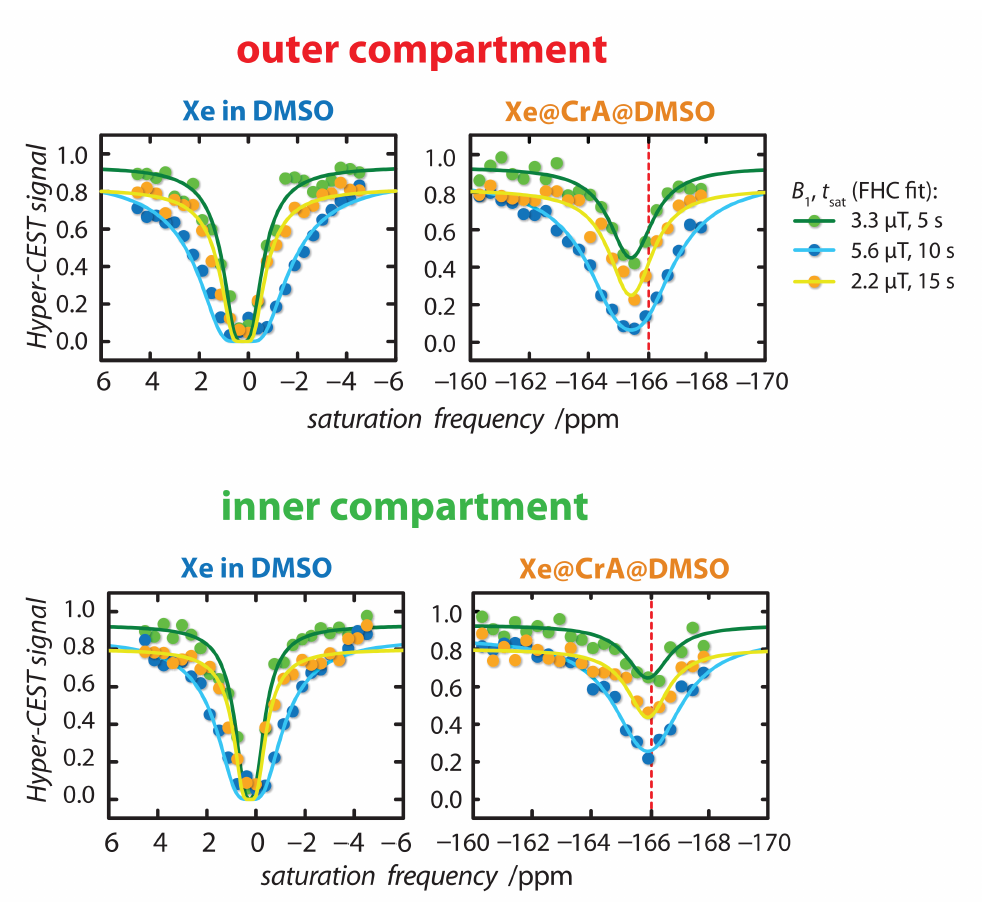
Figure A2. Hyper-CEST z -spectra for data processing exemplary for one pixel in the outer ( top ) and inner compartment ( bottom ) of the double bubbling phantom. The Hyper-CEST z -spectra (dots) were globally fitted (a set of three spectra for each pixel) with the full Hyper-CEST (FHC) model (solid lines) for B 1 / t sat = {3.3/5 (green), 5.6/10 (blue), 2.2/15 (orange)} µ T/s. The red dashed line at the Xe@CrA-ma resonance marks a fix line at − 166 ppm to illustrate the chemical shift between the inner and outer compartment. This shift is above the uncertainty of the fit result, i.e., for the inner compartment ∆ δ IC = ± 0.09 ppm and the outer compartment ∆ δ OC = ± 0.04